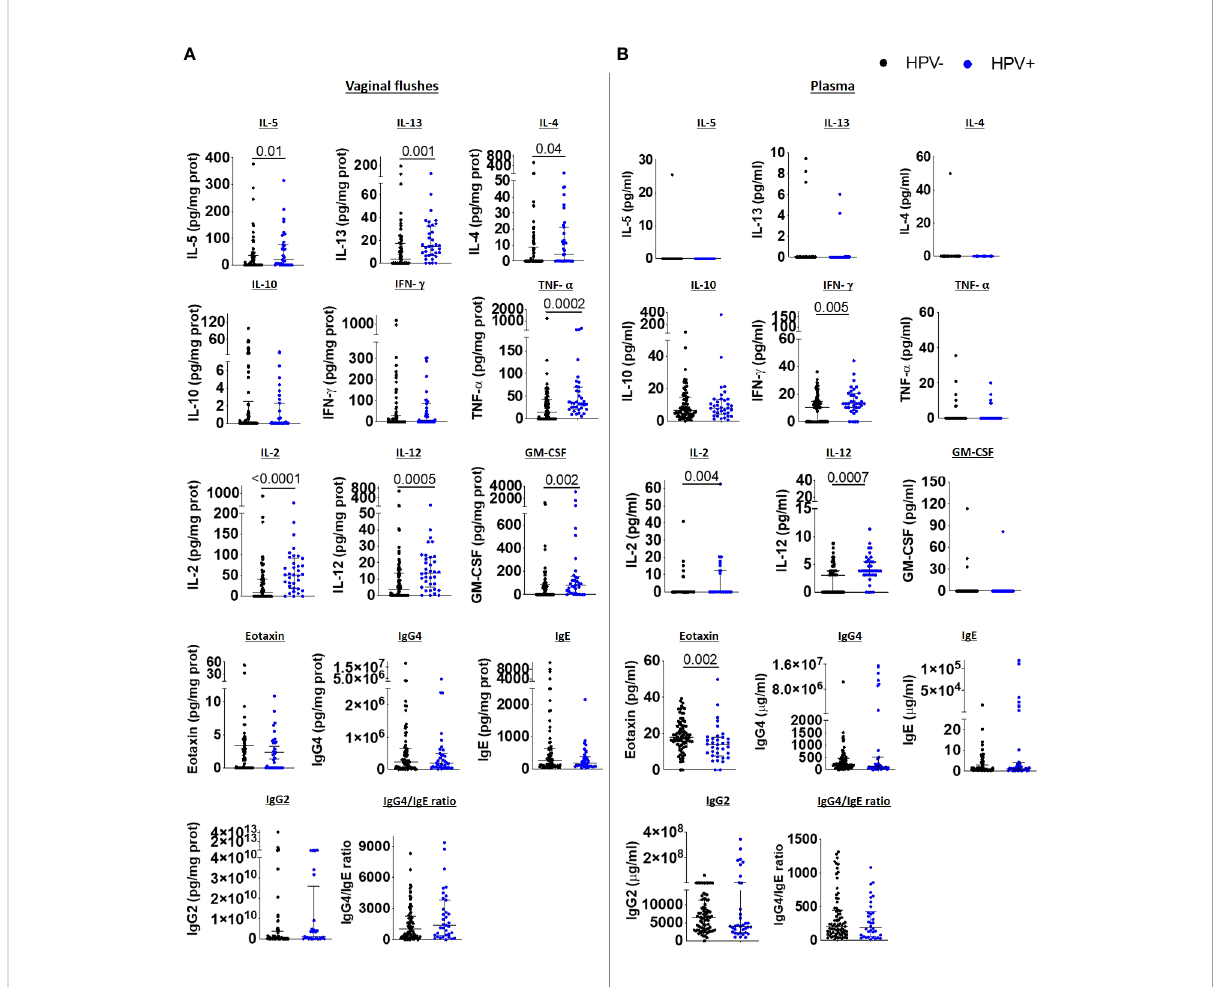
FIGURE 4 HPV infection induces mixed Type 1/Type 2 immune responses in the FRT accompanied with reduced systemic eotaxin levels. IL-5, IL-13, IL-4, IL-10, IFN- g , TNF- a , IL-2, IL-12, GM-CSF, eotaxin, IgG4, IgE, IgG2 levels, and IgG4/IgE ratio in vaginal fl ushes (A) and plasma (B) of HPV- and HPV+ women. Each dot represents a single individual, horizontal bars indicate the median and IQR. To normalize VF data, individual analyte concentrations were expressed as ratio of the measured parameter and the total protein concentration of the sample. HPV- (n=78) HPV+ (n=35). A Mann Whitney U test was used to compare HPV- and HPV+